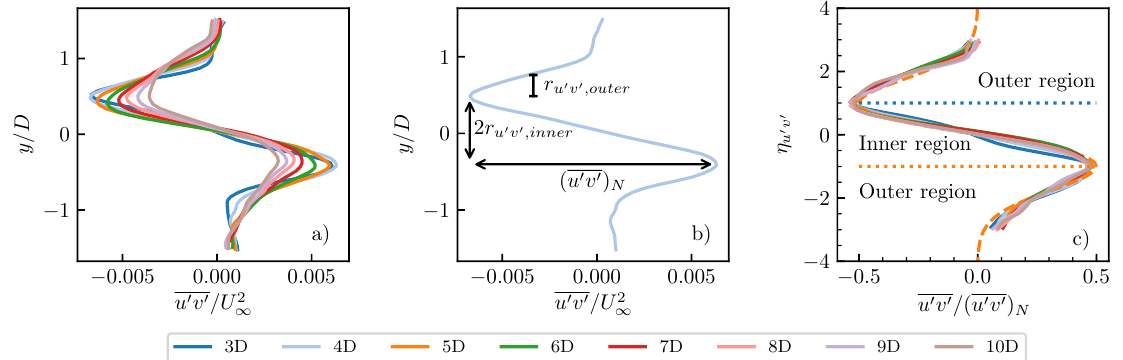
Figure 12. The normalization for the spanwise profile of the Reynolds stress component u (cid:48) v (cid:48) . In ( a ), the spanwise profiles are normalized by a fixed scale for all downstream distances. In ( b ), the definitions of the characteristic scales in u (cid:48) v (cid:48) are annotated. In ( c ), the spanwise profiles in 3 normalized by the characteristic scales. The vertical coordinate η u The dashed line in ( c ) is the theoretical solution Equation (19) for the normalized profile of u (cid:48) v (cid:48) . The dotted lines in ( c ) are the boundaries of the inner and the outer regions for the spanwise distribution.